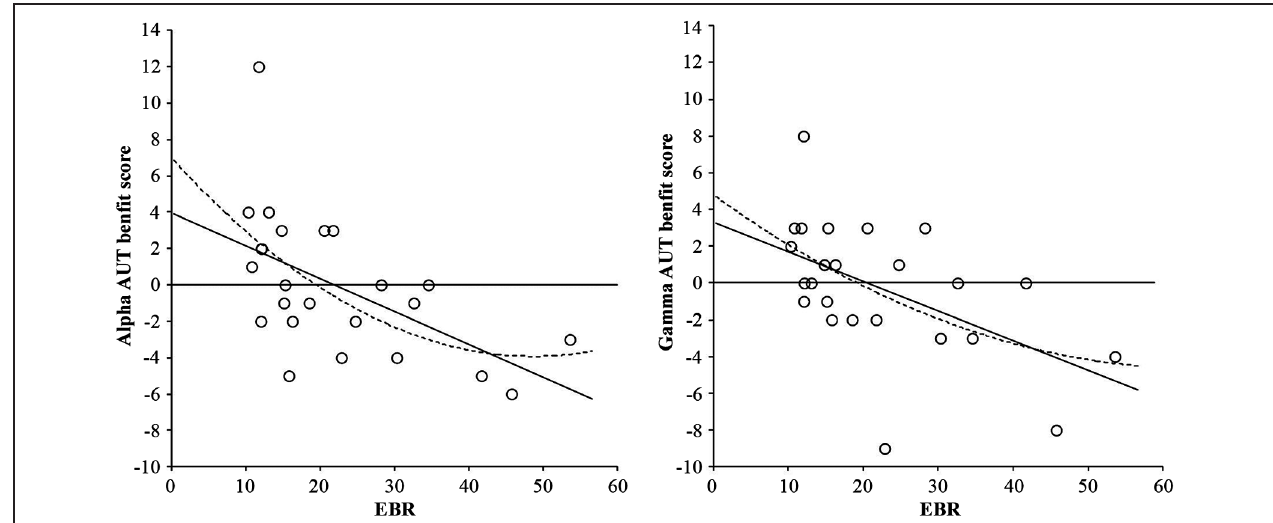
gamma frequency binaural beats and EBR (right-hand graph) . Benefit scores were calculated by subtracting performance in the control condition from performance in the binaural beat condition (either alpha or